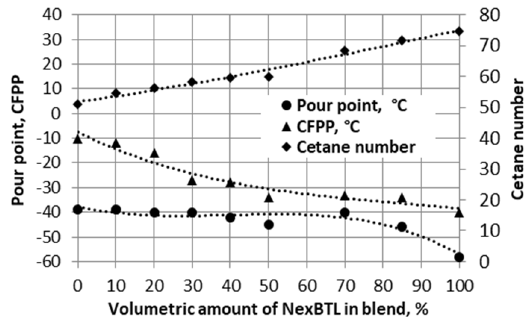
Figure 4. Dependence of the pour point, cold filter plugging point and cetane number on the percentage of NexBTL in fuel blends.